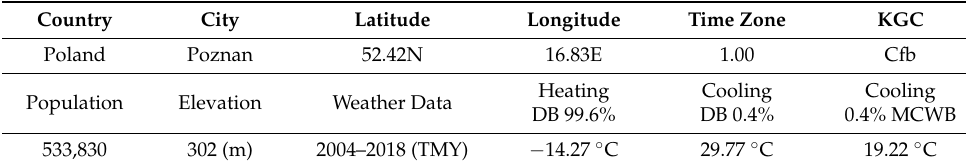
Table 1. A short description of the research case study. Country